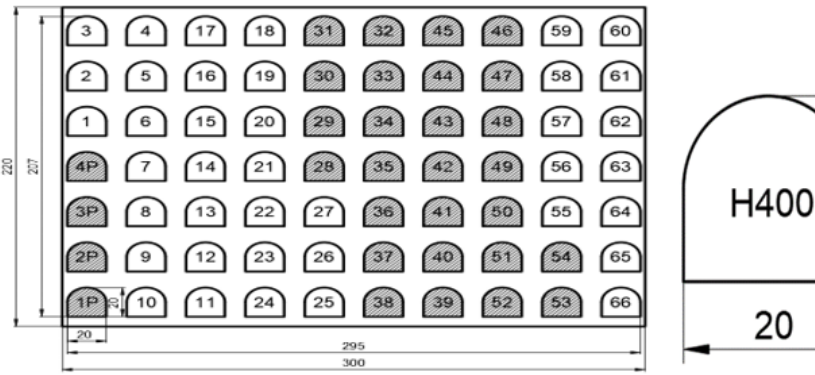
Figure 1. Cutting plan and dimensions of the semi-finished product.